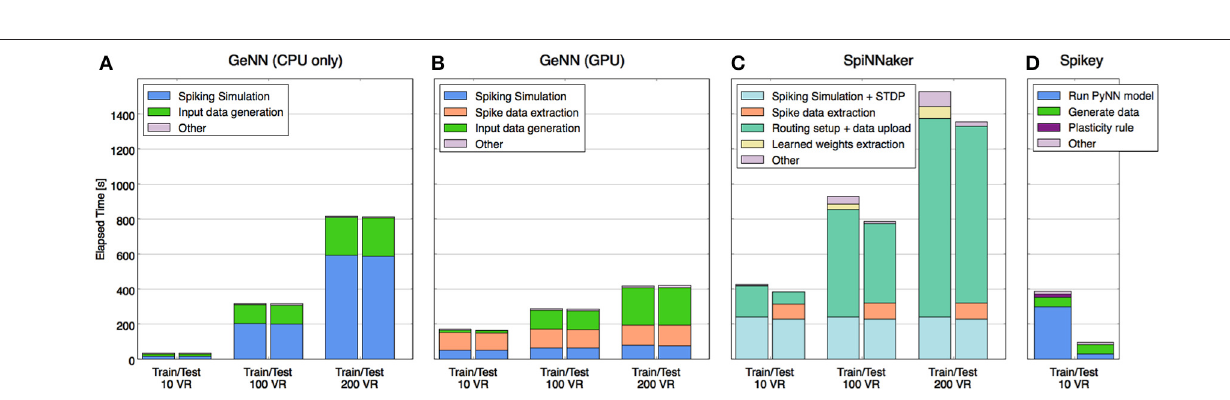
the makeup of the time expended for each platform are shown